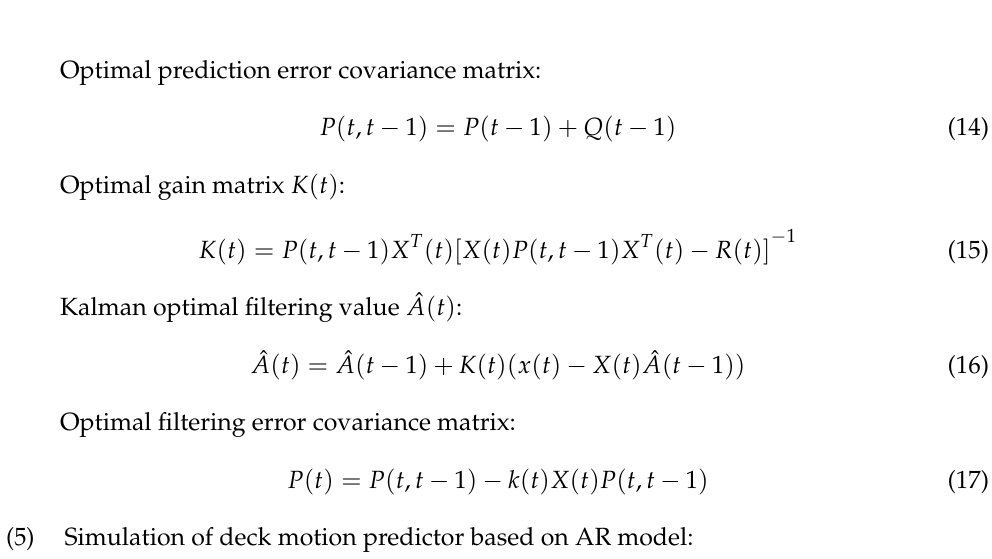
Figure 7. Height of the ideal landing point and its estimated error (encounter angle of / 3  , level − 5 sea state, navigation speed of 18 knots).